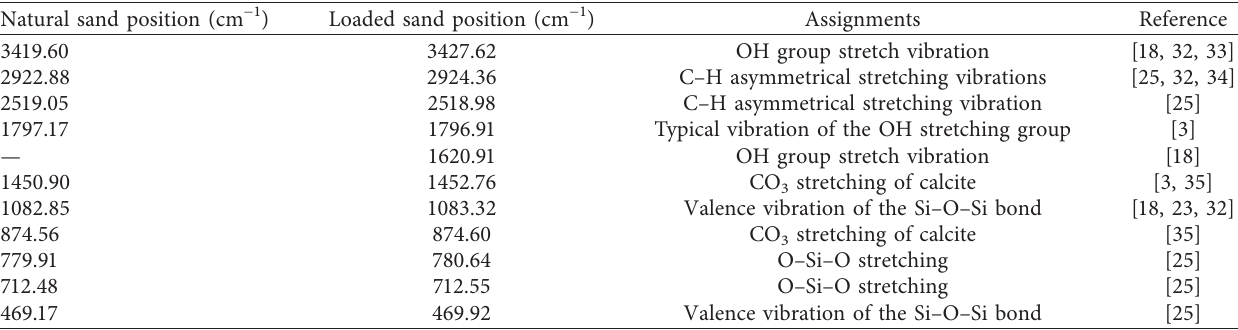
Figure 4: Infrared spectrum of natural sand (NS) and loaded sand Table 2: Sand infrared bands and their assignments.